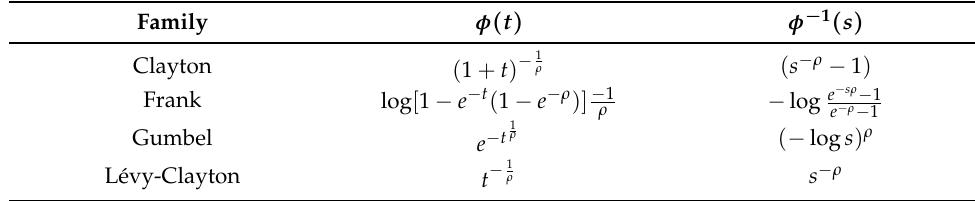
Table 1. Archimedean copula generator functions and inverse